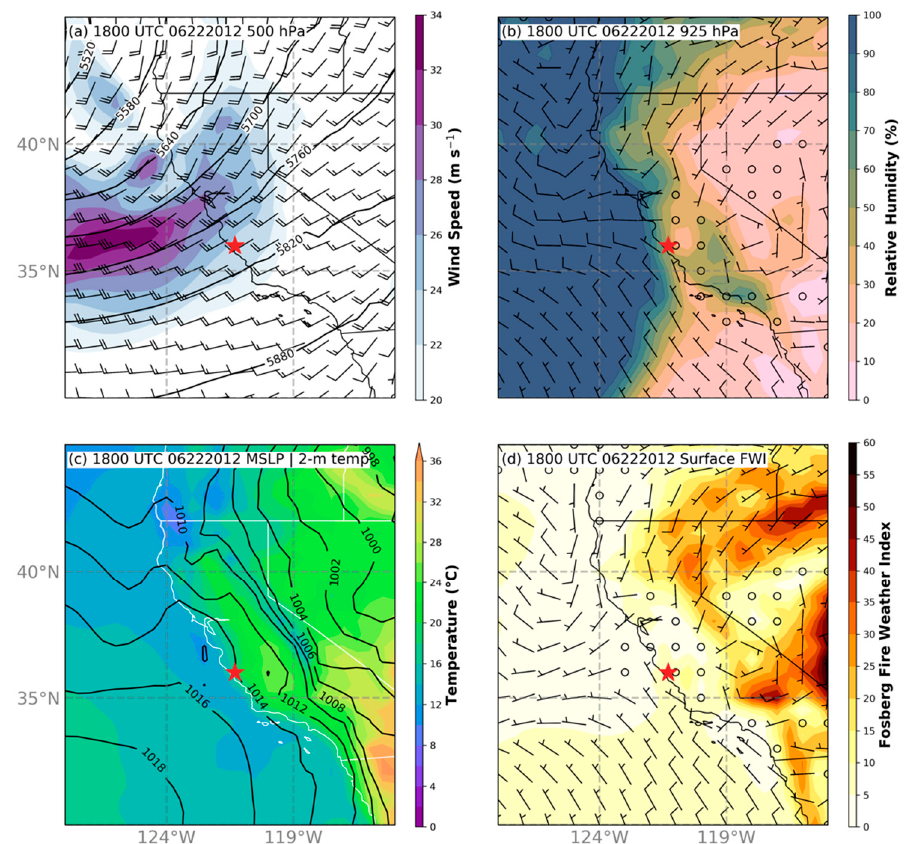
Figure 3. Global Forecast System reanalysis of ( a ) 500 hPa wind speed and height contours, ( b ) 925 hPa relative humidity, ( c ) mean sea-level pressure (MSLP) and 2-m air temperature, ( d ) surface Fosberg Fire Weather Index. Experiment site is indicated by the red star.